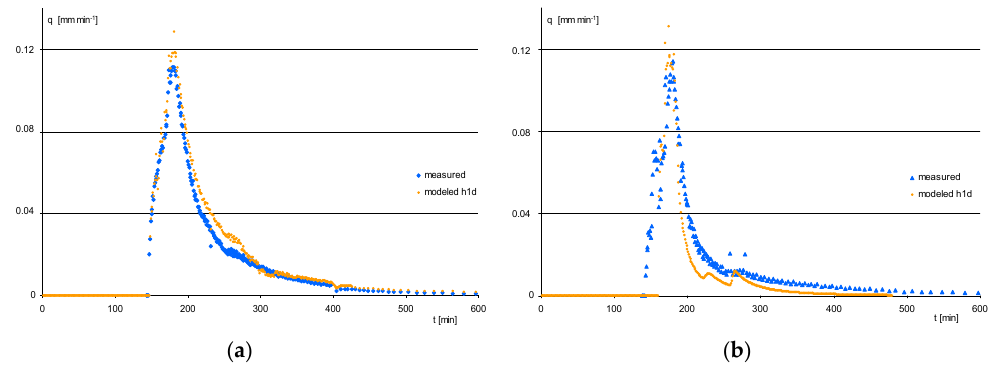
Table 3. Rainfall and runoff characteristics of the studied events. Substrate depth 11 cm zeolite and pumice.